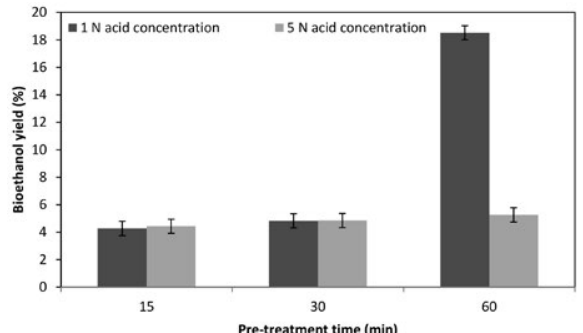
Fig 6. Effect of different acid pre-treatment times on bioethanol yield